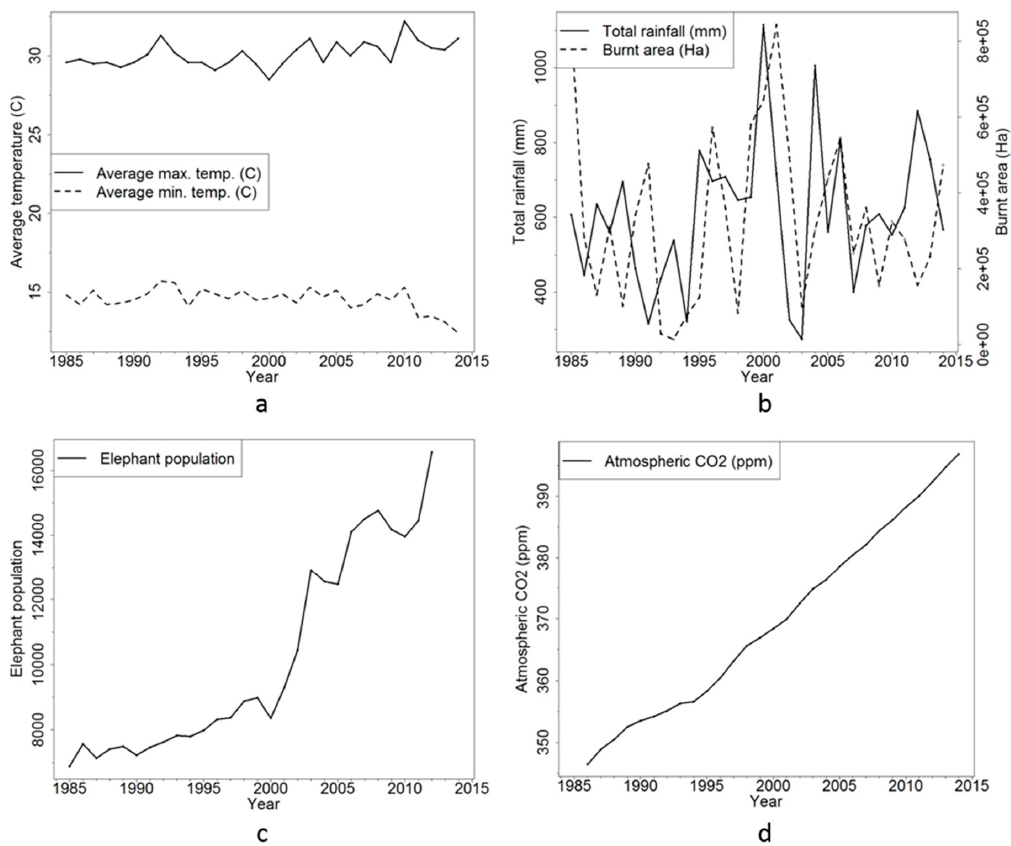
Figure 9. Potential environmental drivers of land cover change and woody encroachment: ( a ) mean annual maximum and minimum temperature; ( b ) total rainfall and total burnt area; ( c ) elephant population; and ( d ) mean annual atmospheric CO 2 (ppm) from the Mahe Island (Seychelles) recording site [79].